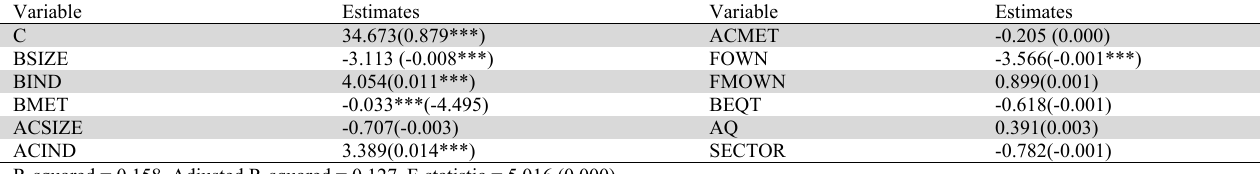
Impact of CG mechanisms on Compliance with IFRS (Model 1)